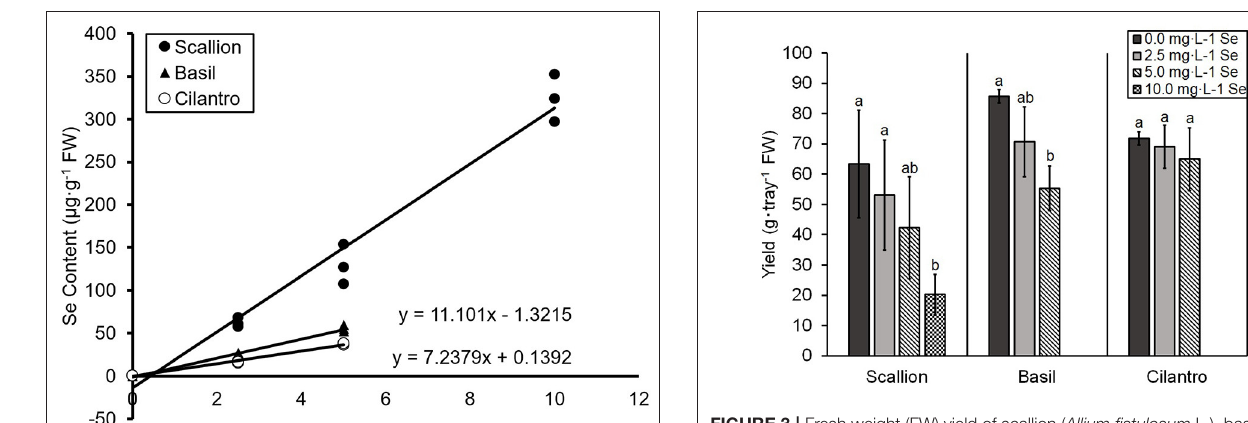
FIGURE 3 | Fresh weight (FW) yield of scallion ( Allium fistulosum L.), basil ( Ocimum basilicum L.), and cilantro ( Coriandrum sativum L.) microgreens treated with various concentrations of selenium (Se) as sodium selenate. Bars indicate mean ± standard deviation (SD) for three replicates ( n = 3) of basil and cilantro and six replicates ( n = 6) for scallion. The Tukey’s significance at P ≤ 0.05 among Se treatments is indicated by different letters within the plant